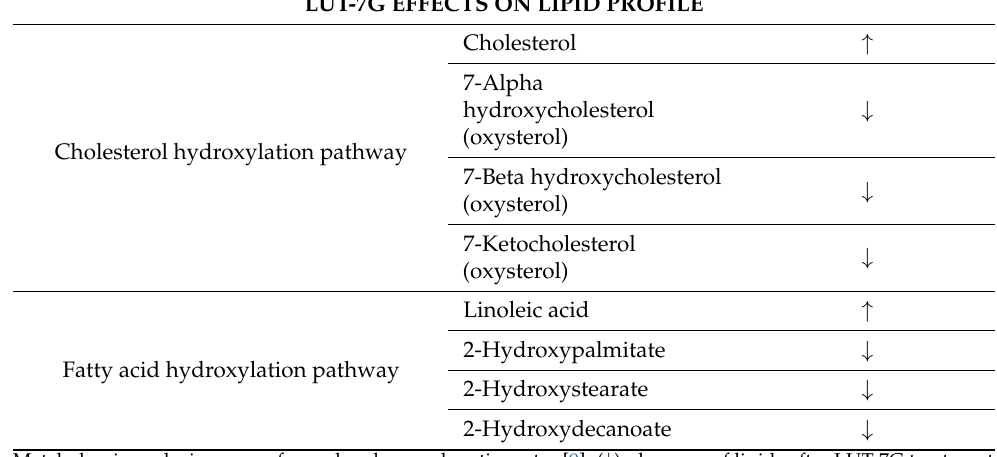
Table 8. Effects of LUT-7G (20 µ M) on lipid